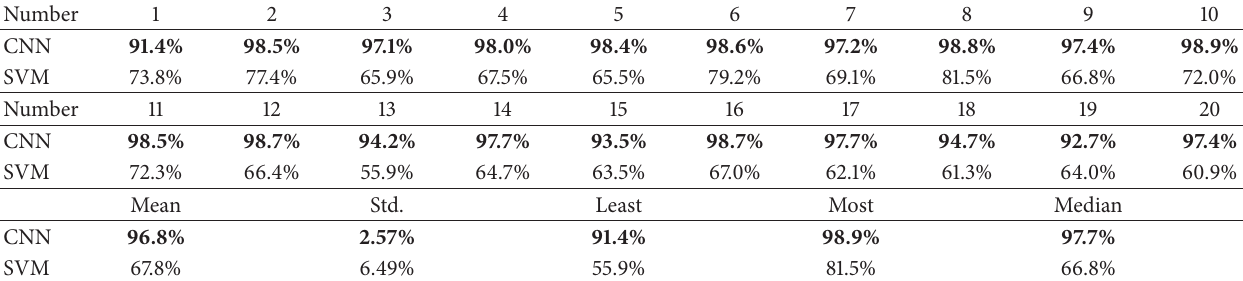
Table 5. The experiment results of 20 test cases using the SVM method are shown in Table 8. Its global percentage of true positive classification of the 12 condition patterns of faults is only 69.0% and the total error is 31.0%. The smallest percentage of true positive classifications is 30% of type